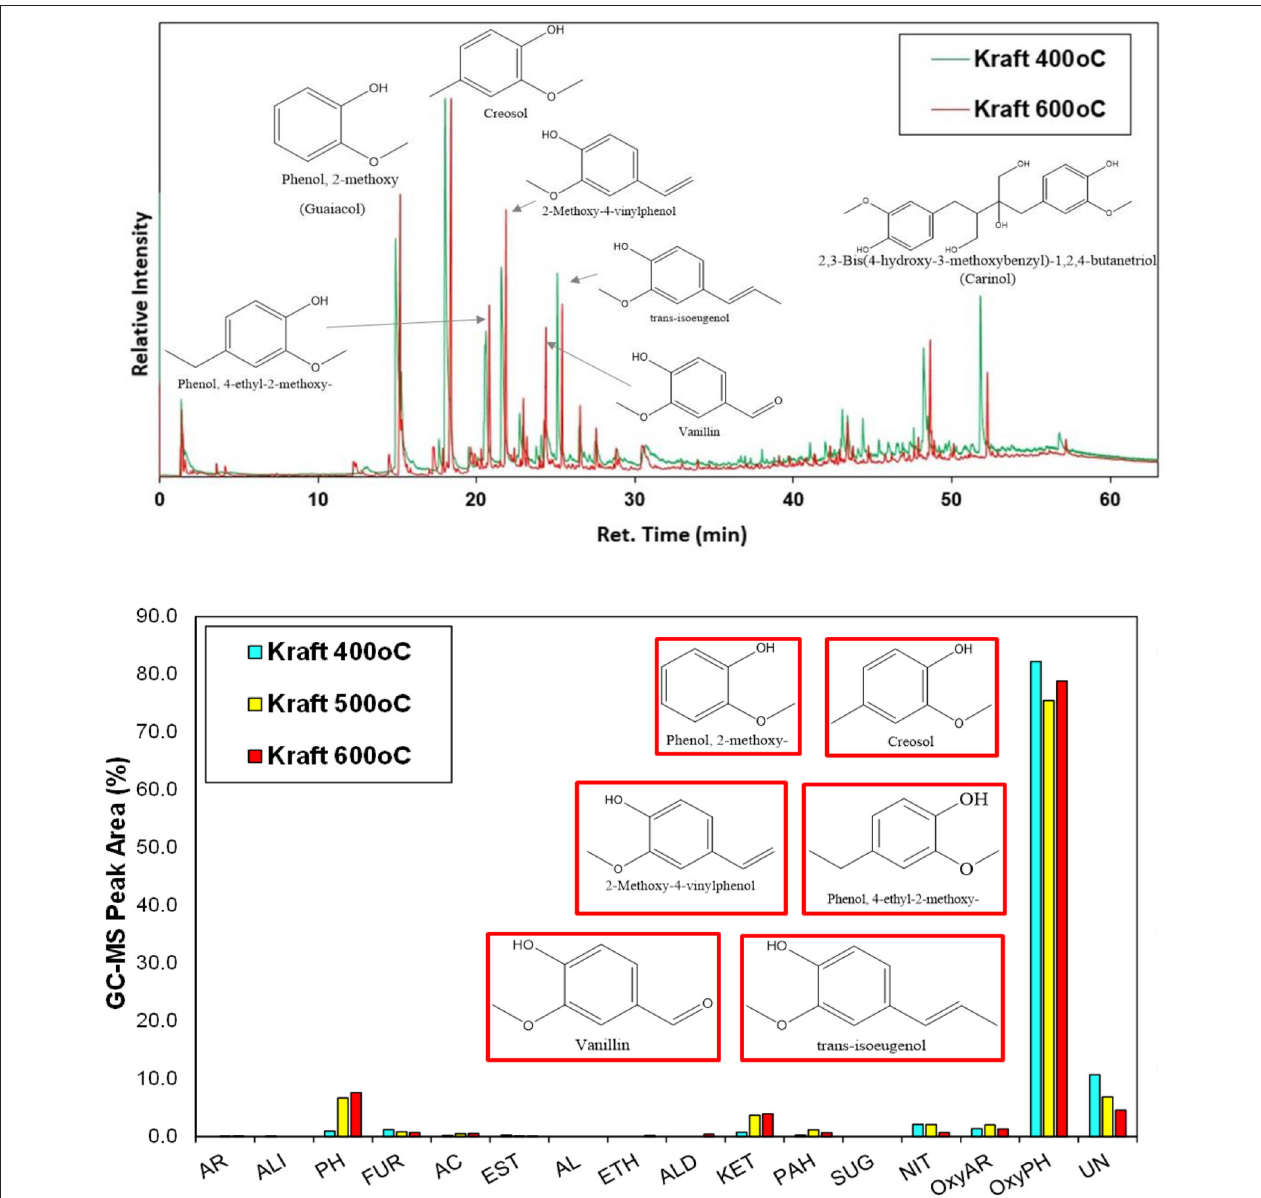
FIGURE 5 | Representative Py/GC-MS spectra of non-catalytic (thermal) fast pyrolysis of kraft (spruce) lignin (up), and relative concentration of the various groups of compounds in the bio-oil (down); indicated compounds in the graph are for the experiment at 600 ◦ C.